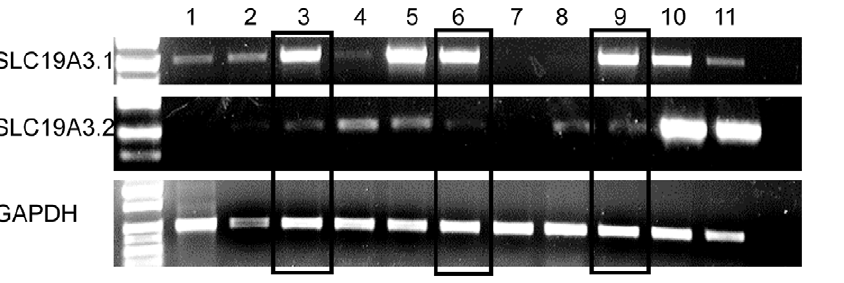
Figure 6. The relative tissue specific expression levels of the two paralogs of SLC19A3 and GAPDH. RT PCR products obtained from equal amounts of cDNA are shown from the following tissues: 1 spleen, 2 skin, 3 cerebellum, 4 thymus, 5 testis, 6 spinal cord, 7 heart, 8 muscle, 9 cerebral cortex, 10 kidney, and 11 liver.